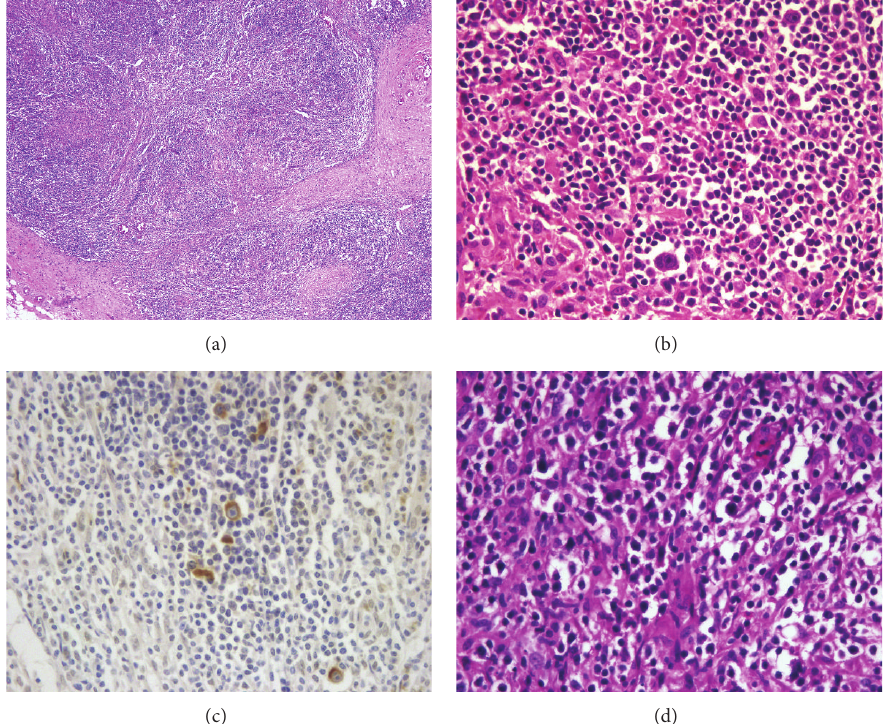
Figure 2: (a) The lymph node shows nodules separated by broad bands of fibrosis. (b) Reed-Sternberg cells and their variants are in the nodules. (c) Reed-Sternberg cells are CD30 positive. (d) Atypical lymphoid cells have hyperchromatic nuclei with discernible